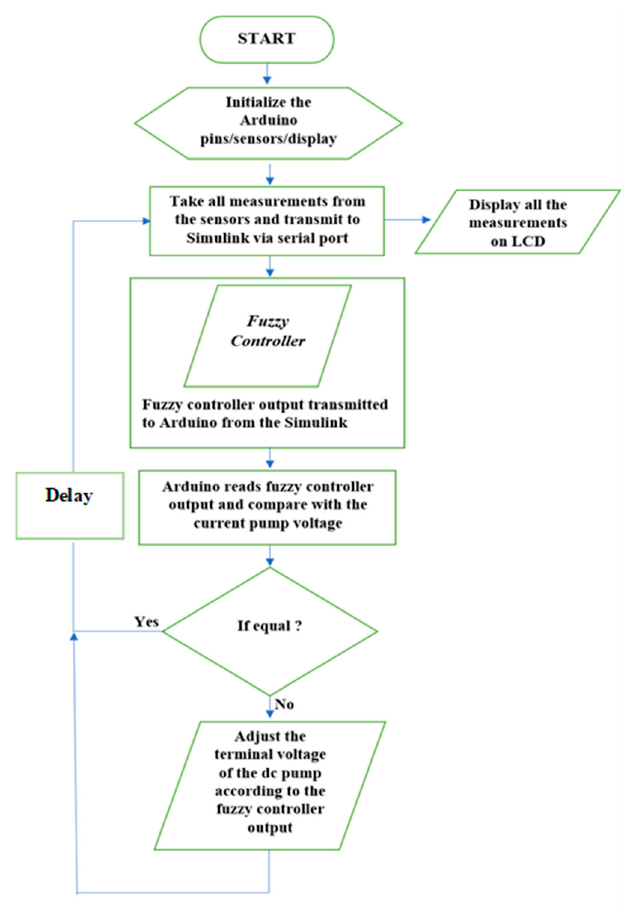
Figure 19. Flow chart of the control algorithm.